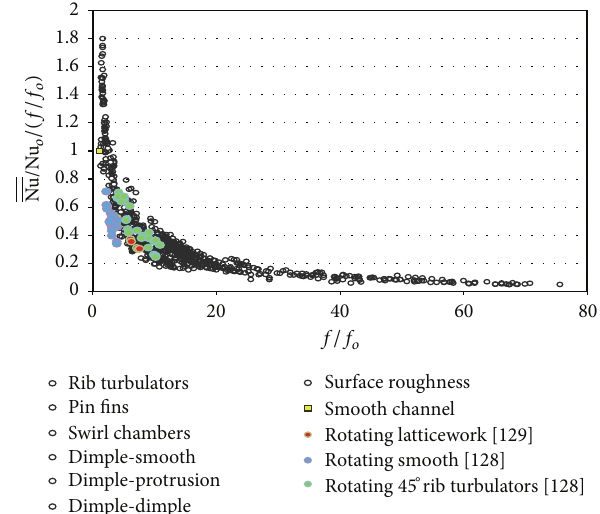
Figure 32: Comparisons of relative performance of rib turbulators, pin fins, swirl chambers, dimple-smooth arrangements, dimple- protrusion arrangements, dimple-dimple arrangements, surface roughness, and smooth-walled channels [1], with results from rotation experiments [128, 173]. Globally averaged thermal perfor- manceparametersNu / Nu 𝑜 /(𝑓/𝑓 𝑜 ) arepresentedasdependentupon friction factor ratios 𝑓/𝑓 𝑜